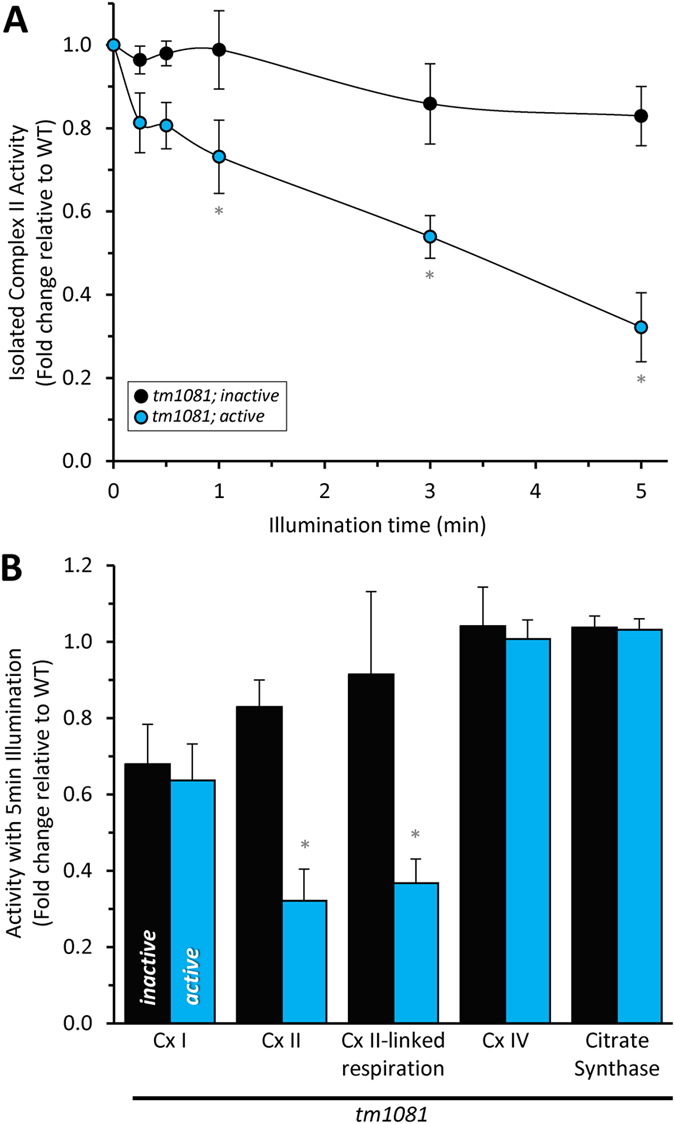
Light-induced loss of complex II activity.Mitochondria were isolated from wild-type (+), tm1081; inactive, and tm1081; active strains. The isolated mitochondria were then exposed to varying periods of illumination and: (A) Assayed for complex II (succinate-ubiquinone reductase) activity. Data at all time points were normalized to wild-type (+) values, to account for miniSOG-independent effects of blue light, as well as to baseline complex II activity for each strain. The “pre-light” values (in nmol DCPIP/min/mg) were: wild-type (+), 13.5 ± 2.6; tm1081; inactive, 9.2 ± 0.5; and tm1081; inactive, 10.9 ± 0.9. *Adjusted P < 0.05 vs the no light or vs the light-matched inactive counterpart (2-way ANOVA with Sidak multiple comparisons test). N = 5–7. (B) Assayed for the activity of other mitochondrial enzymes, complex I (NADH:ubiquinone oxidoreductase), complex IV (cytochrome c oxidase) and citrate synthase. Exposure to light was for 5 min and the data was normalized as in panel A. Baseline complex I activity (N = 5–7): wild-type (+), 77 ± 2.4 nmol NADH/min/mg; tm1081; inactive, 131 ± 14; tm1081; active, 121 ± 9. Baseline complex II-linked respiration (n = 9–10): wild-type (+), 29.5 ± 2.8 nmol O2/min/mg; tm1081; inactive, 12.1 ± 1.0; tm1081; active, 12.6 ± 1.0. Baseline complex IV activity (N = 7–10): wild-type (+), 35.4 ± 3.1 nmol O2/min/mg; tm1081; inactive, 34.3 ± 2.3; tm1081; active, 34.3 ± 1.6. Baseline citrate synthase activity (N = 5–18): wild-type (+), 356 ± 19 nmol DTNB/min/mg; tm1081; inactive, 568 ± 31; tm1081; active, 538 ± 31. *Adjusted P < 0.01 vs light-matched inactive counterpart (2-way ANOVA with Sidak multiple comparisons test). All data are mean ± SEM. An “N” is an independent mitochondrial isolation. Alleles are abbreviated as outlined in Fig. 1.